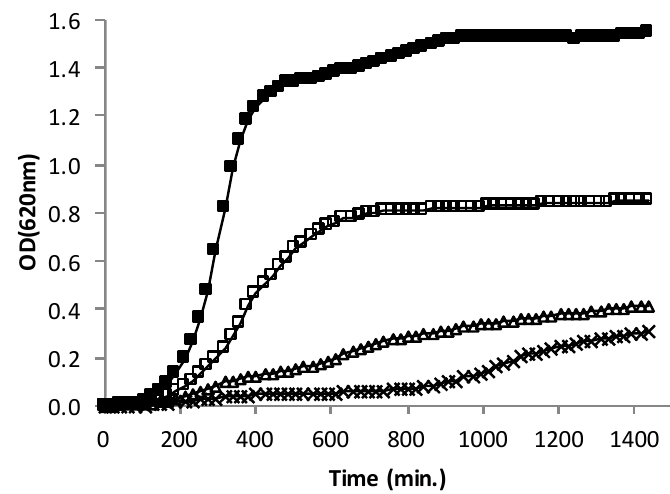
Figure 1. Representative growth curves of MRSA CIP106760 ( (cid:4) ) and CIP106760, challenged with di ff erent concentrations of 7 α -acetoxy-6 β -hydroxyroyleanone; ( (cid:3) ) half the MIC (3.9 mg / L); ( ∆ ) MIC (7.8 mg / L); ( (cid:54) ) double the MIC (15.6 mg / L). Growth was monitored by measuring the OD 620nm for 24h in a microplate reader.